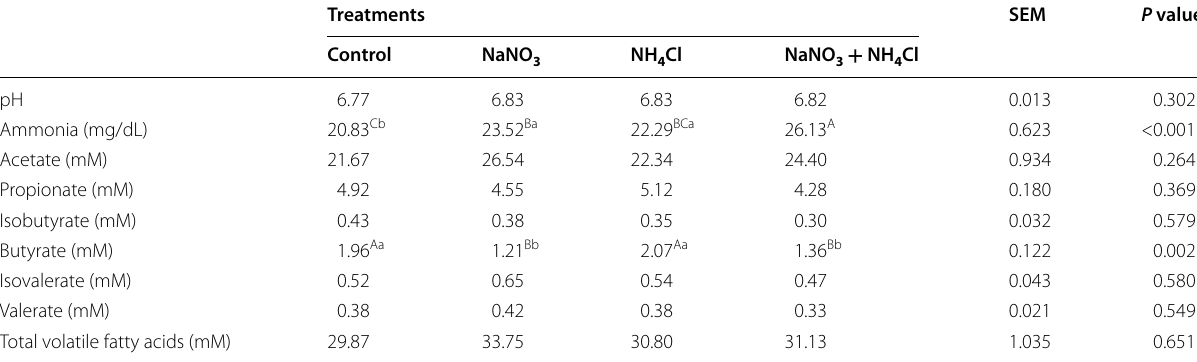
Table 3 Effects of treatments on fermentative characters in ruminal culture